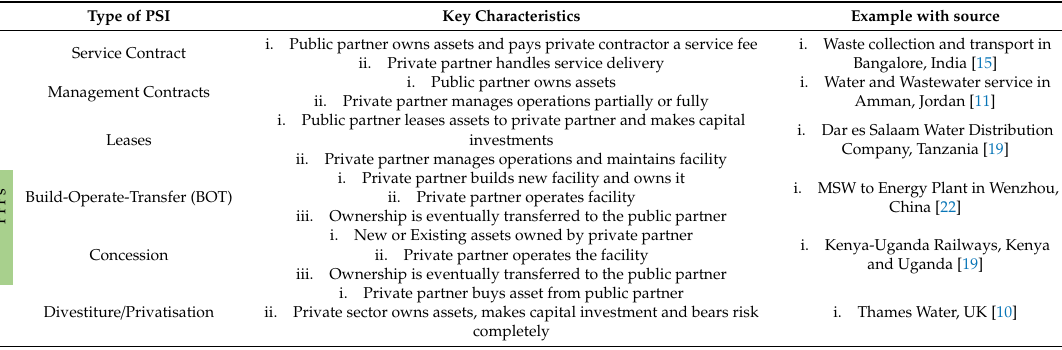
Table 1. Description of types of PSI with examples from other